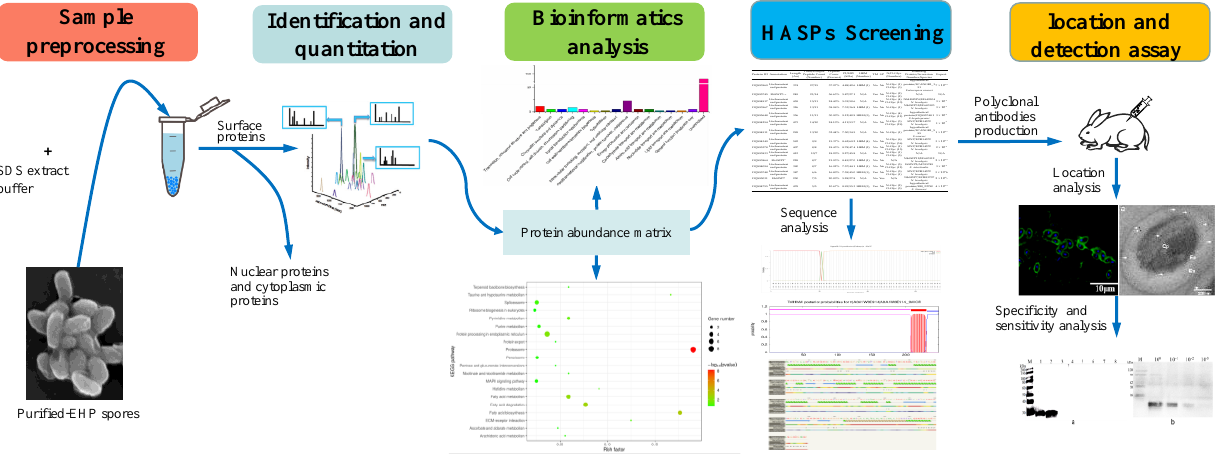
Figure 1. Flow chart of surface proteins analysis, identification, and characterization of EhSWP3. Surface proteins were extracted using the improved SDS method from purified EHP spores, inacti- vated by 250 µ M HgCl2, and then were subjected to LC-MS/MS and bioinformatic analysis. Proteins with unique peptides ≥ 5 and coverage ≥ 10% were identified as high-abundance surface proteins (HASPs). Polyclonal antibodies against EhSWP3 (PAbs anti-EhSWP3) were produced by immunized rabbits using the recombinant EhSWP3 and validated by indirect immunofluorescence assay and immunoelectron microscopy. Then, the specificity and sensitivity analysis of PAbs anti-EhSWP3 for EHP was performed.